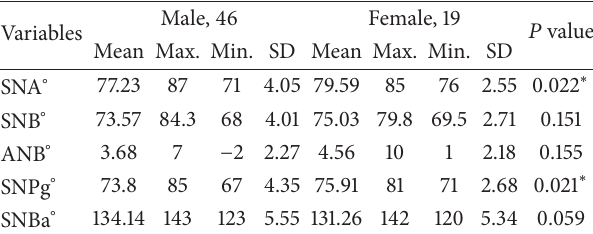
Table 2: The skeletal anteroposterior variables for Yemeni adults with anterior open